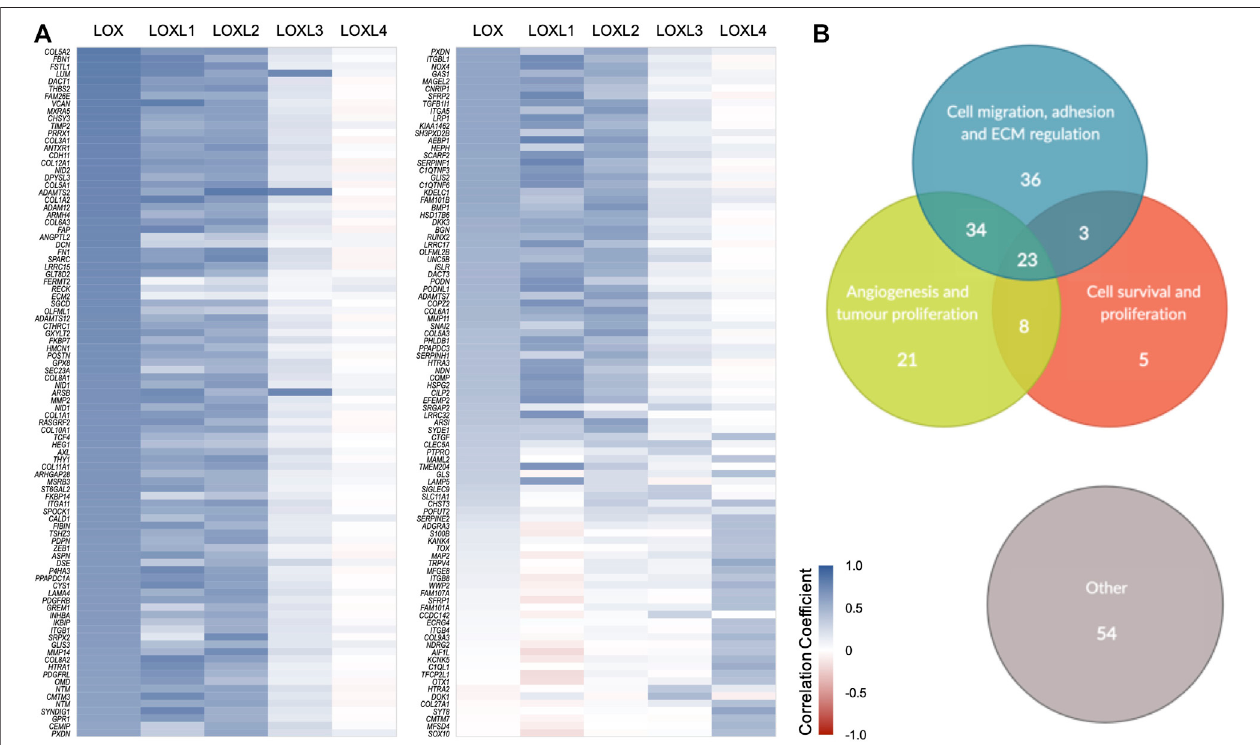
FIGURE 2 | Correlation between the expression of LOX s and other genes in breast cancer. (A) Heat map showing Pearson ’ s correlation coef fi cients between mRNAexpressionof LOX familygenesandothergenes.Foreach LOX ,theonehundredmoststronglycorrelatedgenesinbreastcancerwerecollectedfromGEPIAand UALCAN,andonlythosecommontobothplatformswereselected.BluegradientrepresentsapositivePearson ’ scorrelationandredgradientanegativecorrelation. (B) Genes were clustered according to their described functions, highlighting speci fi c groups that are relevant for breast cancer progression-related events.